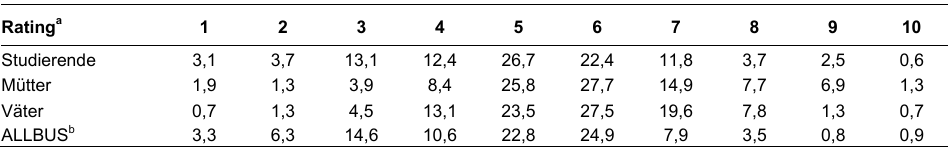
Tabelle 1 : Links-Rechts-Selbsteinschätzung (Prozentsätze) im Vergleich zu